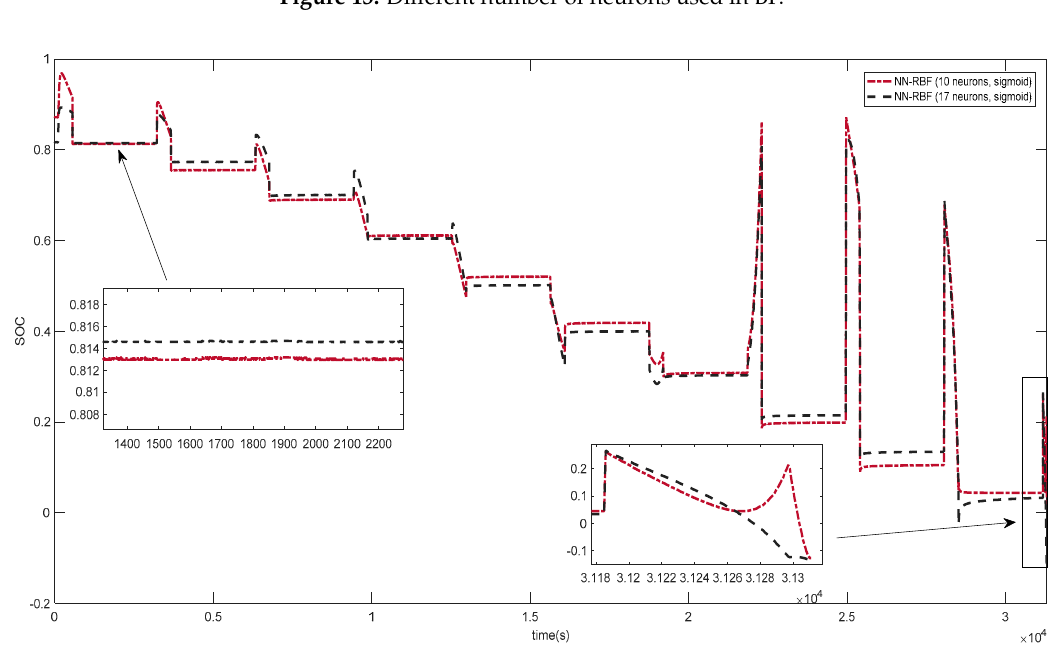
Figure 13. Different number of neurons used in BP.